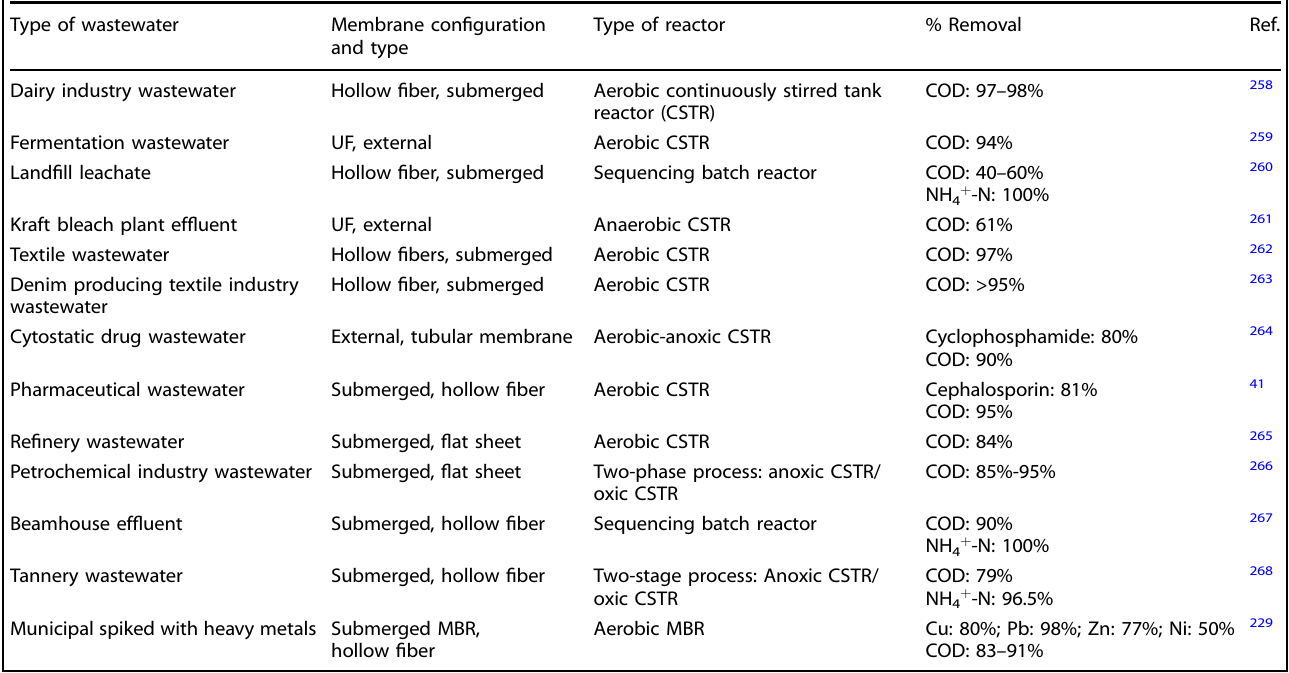
Table 1. Literature data on MBR performance in treating several types of industrial wastewaters. Type of